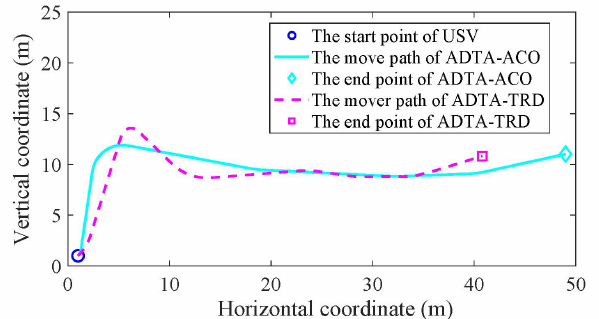
Figure 12. Automatic docking trajectories with translational